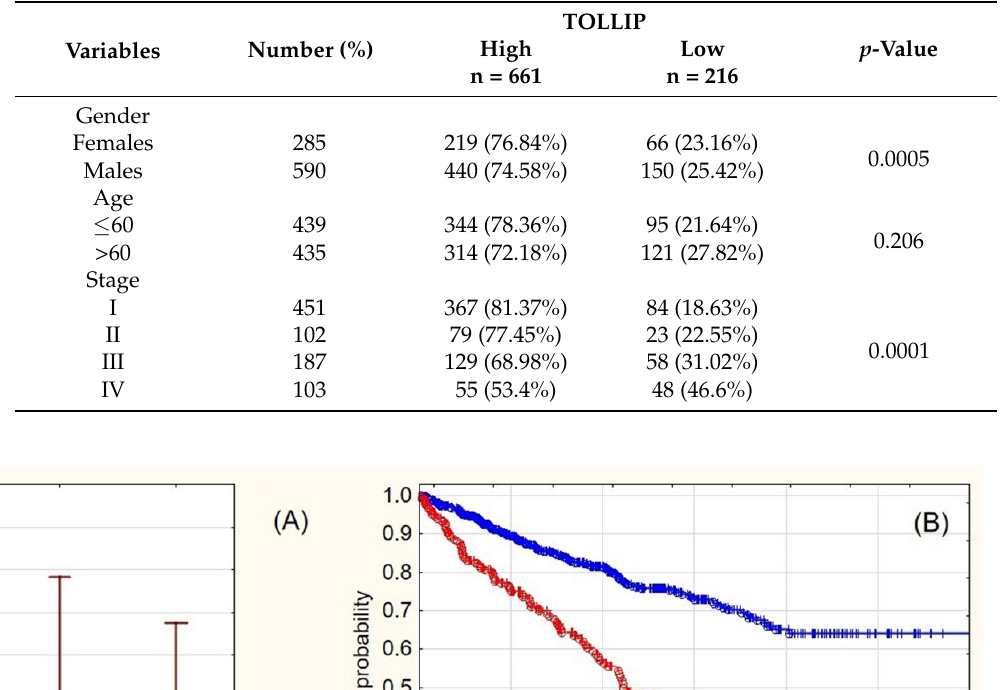
Table 2. Relationship between TOLLIP expression and RCC clinicopathological characteristics.